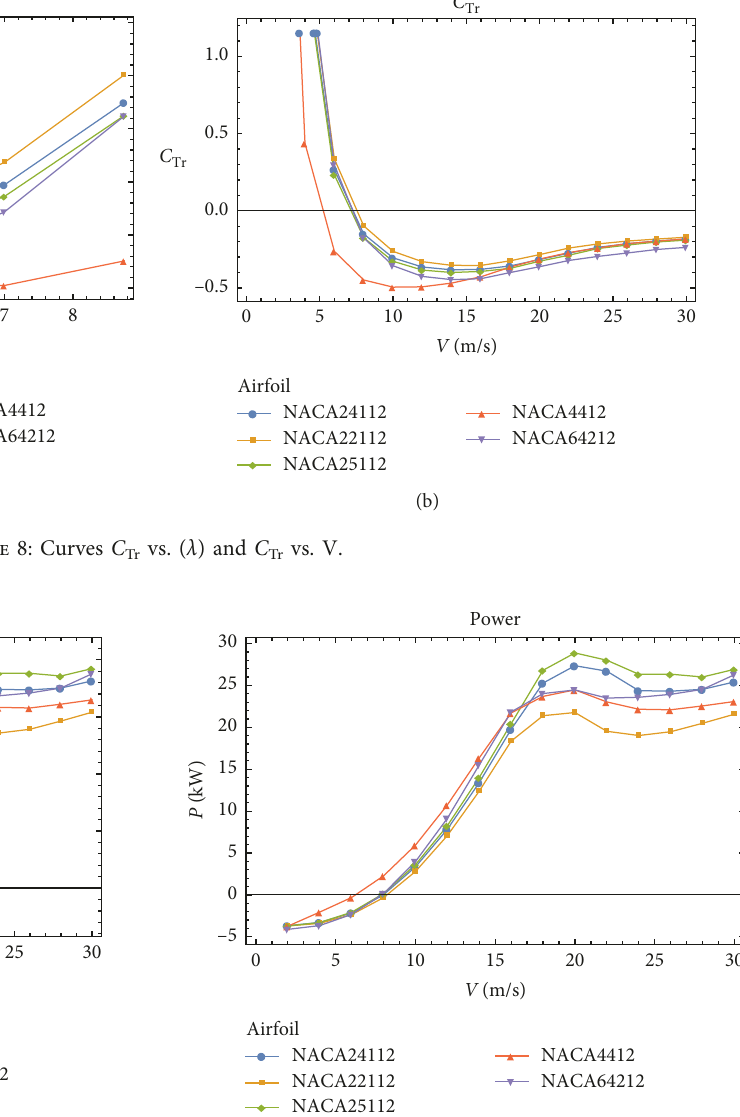
Figure 10: Power evaluation of the wind turbine NACA airfoils at different wind speeds.